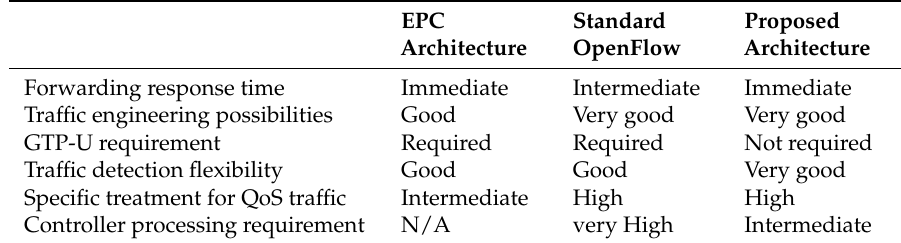
Table 2. Comparison of mobile network architectures. GTP-U, GPRS Tunneling Protocol User